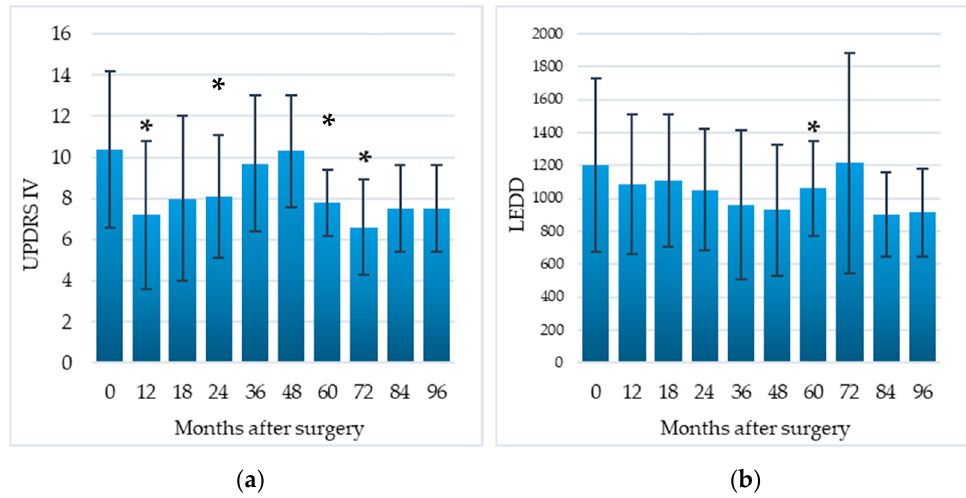
Figure 3. Efficacy of EMCS on motor complications ( a ) and reduction in dopaminergic therapy ( b ) in all patients, evaluated at different times after the implant. Error bars represent standard deviation. * p < 0.05 at comparisons between preoperative and postoperative scores, analyzed by means of the Wilcoxon signed-rank test.